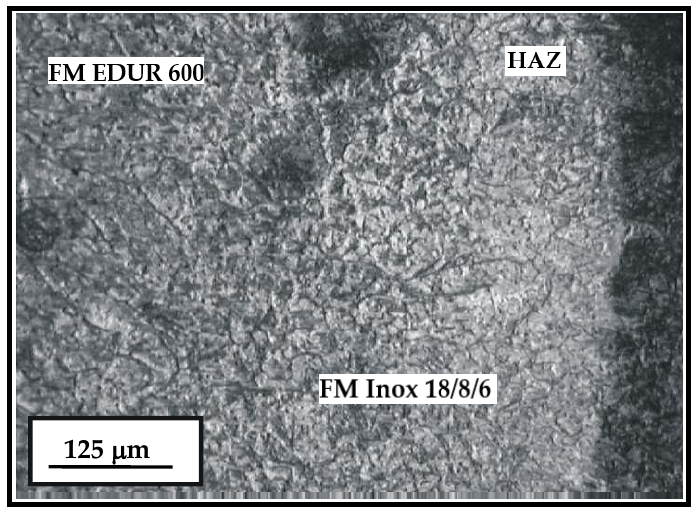
Figure 7. Microstructure of the HAZ and the hard-faced layer with the two filler metals — Inox 18/8/6 + EDUR 600; EDUR 600 — left; Inox 18/8/6 — middle; HAZ — right.